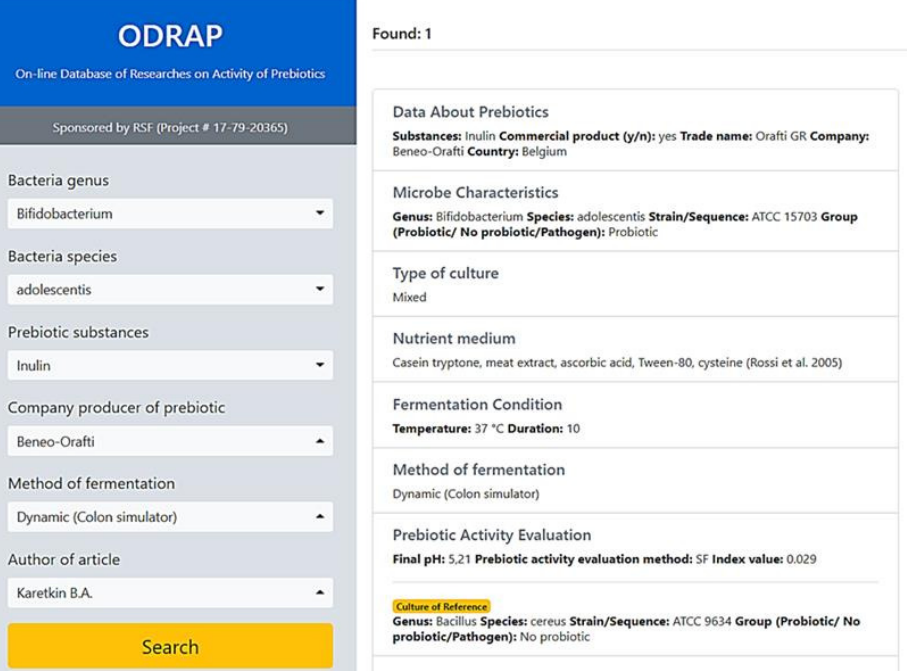
Figure 9. Example of search: synbiotic factor SF obtained from the quantitative model of co-culture suggested for comparison of symbiotic activity against pathogens in different conditions